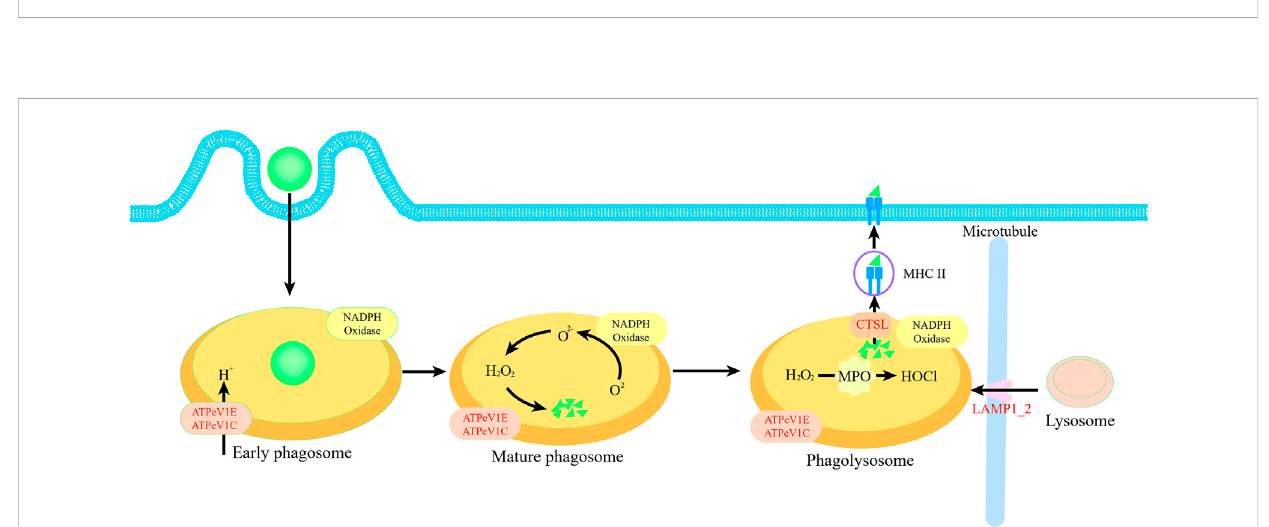
FIGURE 8 Schematicdiagramofphagocytosispathway.FourproteinsATPeV1E,ATPeV1C,LAMP1_2andCTSLinredfontaresigni fi cantlyupregulatedproteins in relation to phagosome